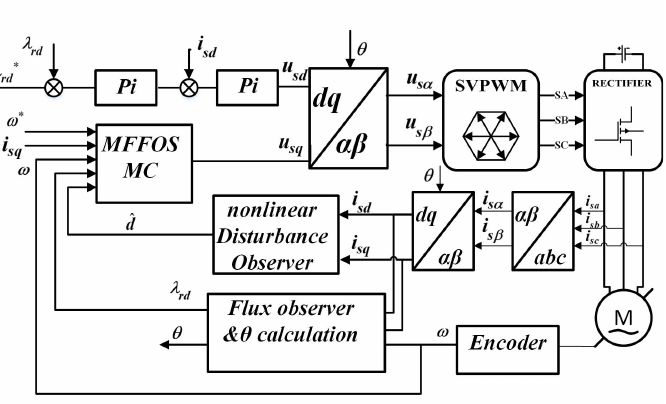
Figure 2. The diagram of the composite control system of AM based on